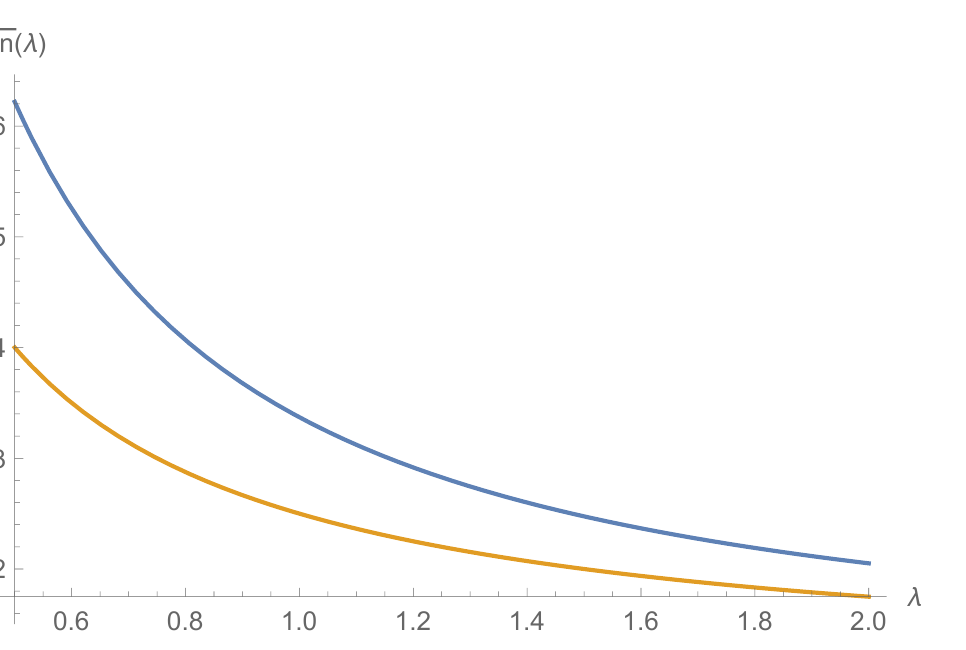
Figure 14. Average energy for free Lorentzian subluminal particles with high λ . The blue line depicts the correct value, while the orange line depicts the Maxwell–Boltzmann approximation.